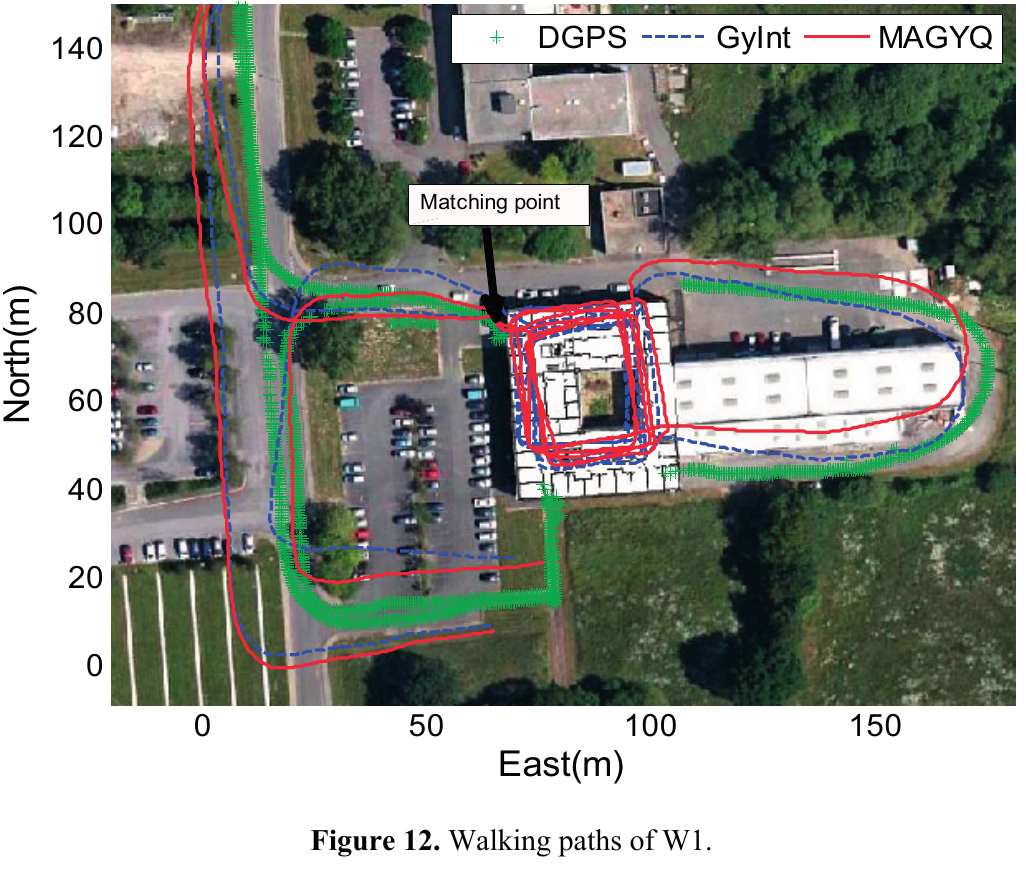
Figure 11. Walking paths of M1.